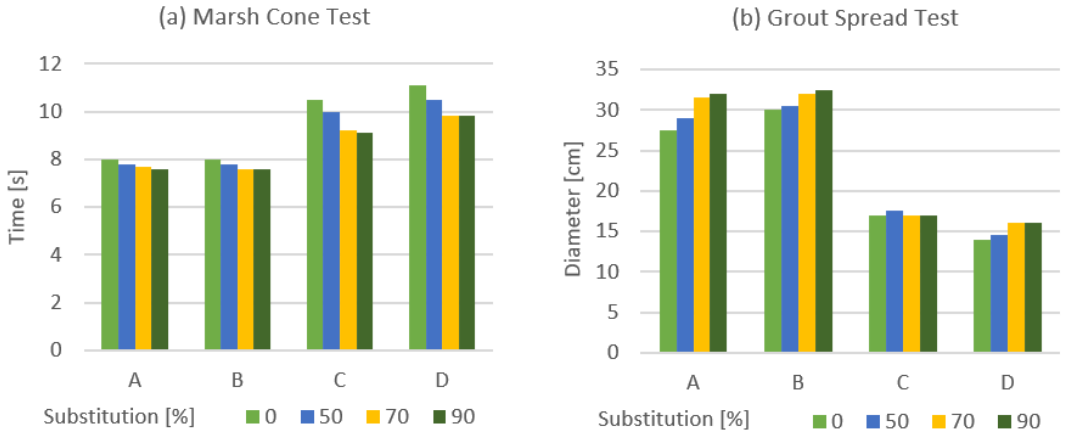
Figure 4. Results of the fluidity test for different mixtures. ( a ) Marsh cone test and ( b ) grout spread test. Consult Table 2 for mixtures identification ( A , B , C, and D ).